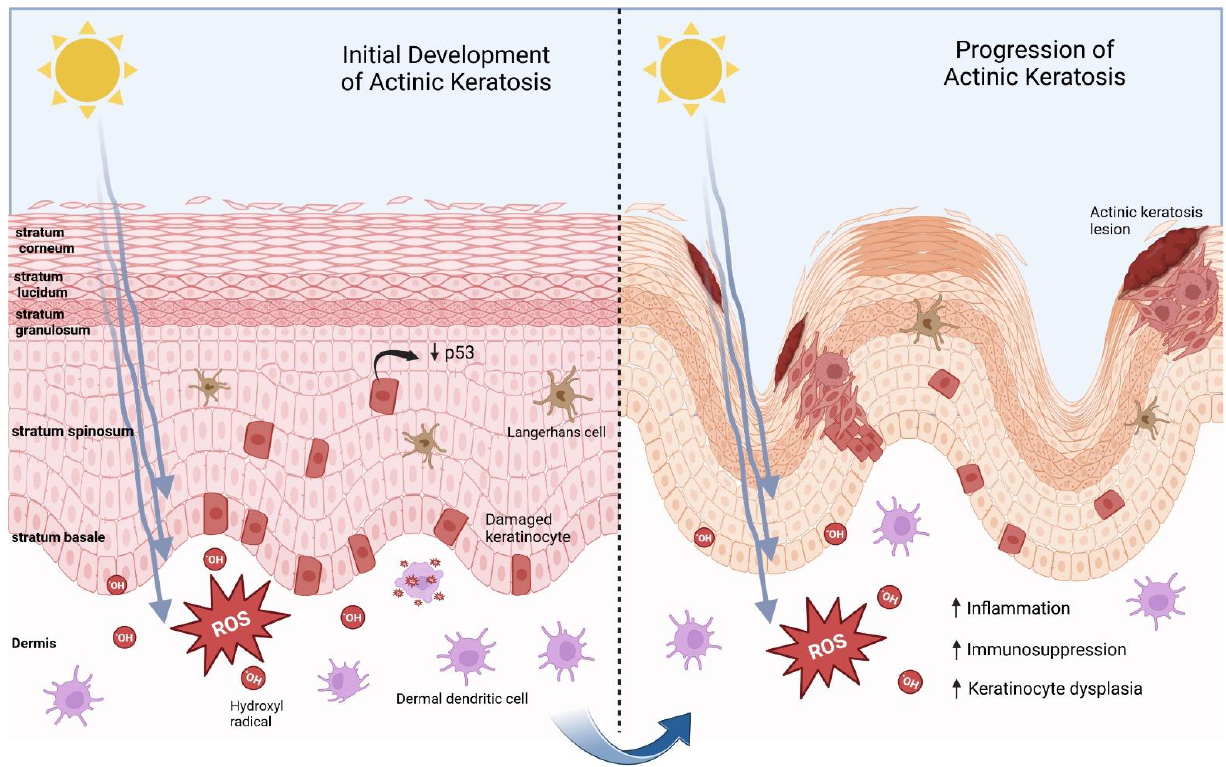
Figure 1. An overview regarding the initiation and progression of actinic keratosis lesions. The process is primarily driven by UVB-mediated keratinocytic DNA damage in the basal layer of the epidermis, particularly implicating tumor suppressor gene, p53. UVA-mediated reactive oxygen species (ROS) formation in the context of hydroxyl radical production in the dermis also promotes a pro-inflammatory, pro-tumorigenic environment via suppression of immune homeostasis and function. These factors combined allow for keratinocyte dysplasia to continue unchecked, eventually leading to the formation of visible actinic keratosis lesions on the surface of the epidermis.